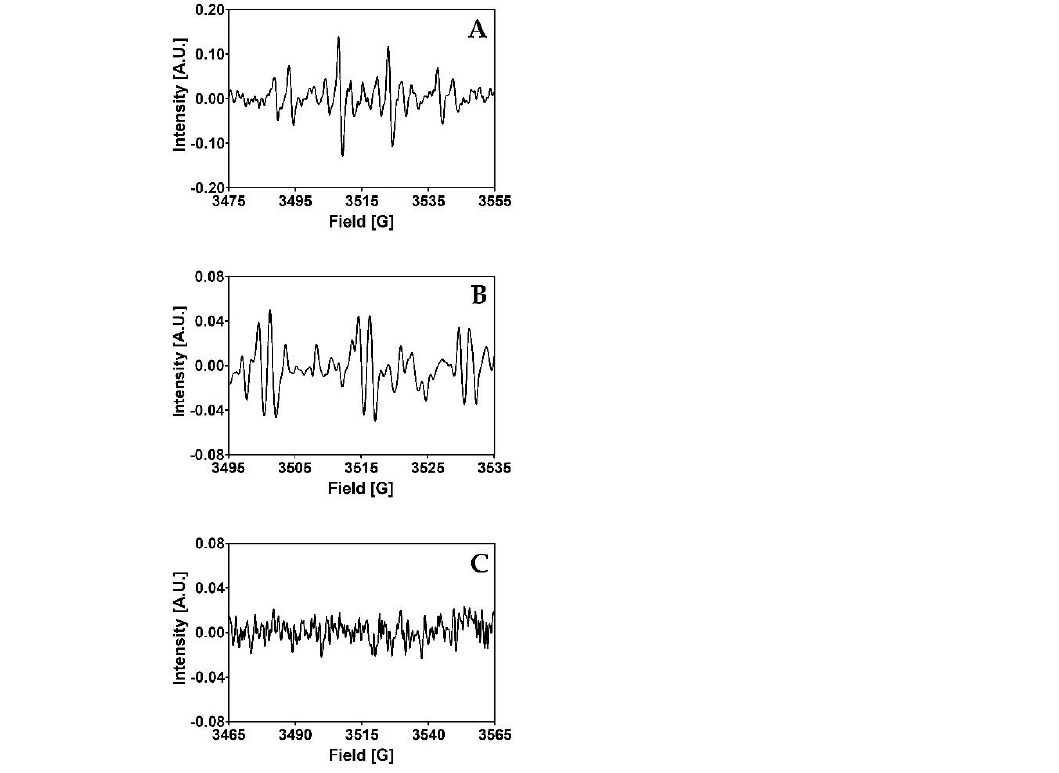
Figure 8. In situ EPR signal observed in oxofunctionalization of benzyl alcohol under visible light irradiation by a 400 W metallic halide lamp driven by TiO 2 using the spin traps. ( A ) DMPO; ( B ) POBN and ( C ) PBN.